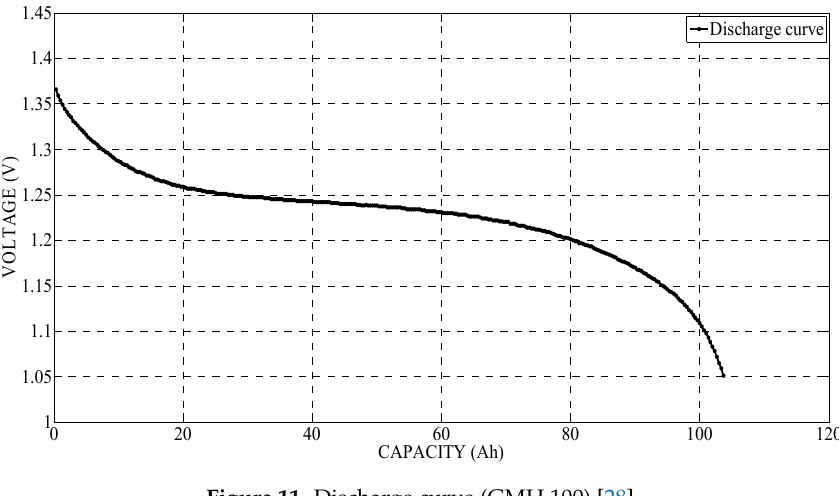
Figure 11. Discharge curve (GMH 100) [28].